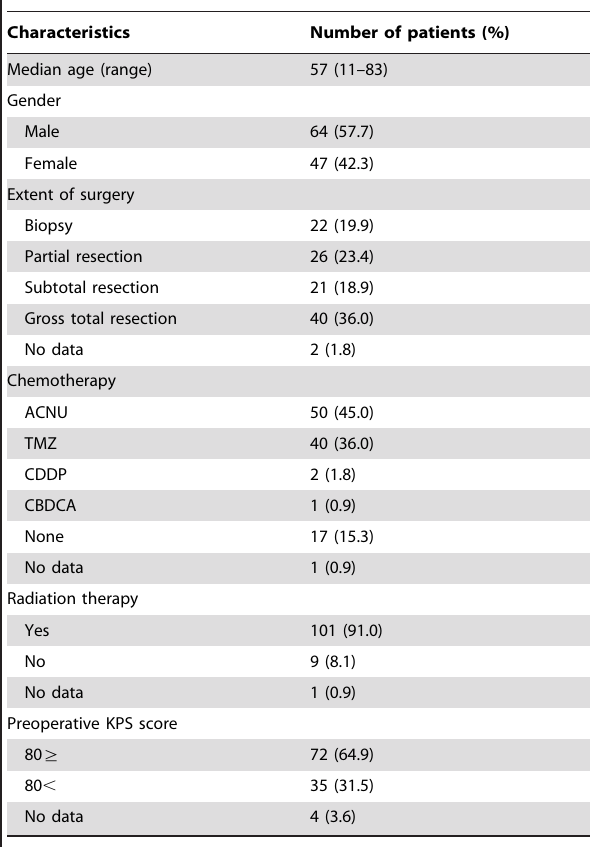
Table 3. Final diagnosis of the 111 cases.